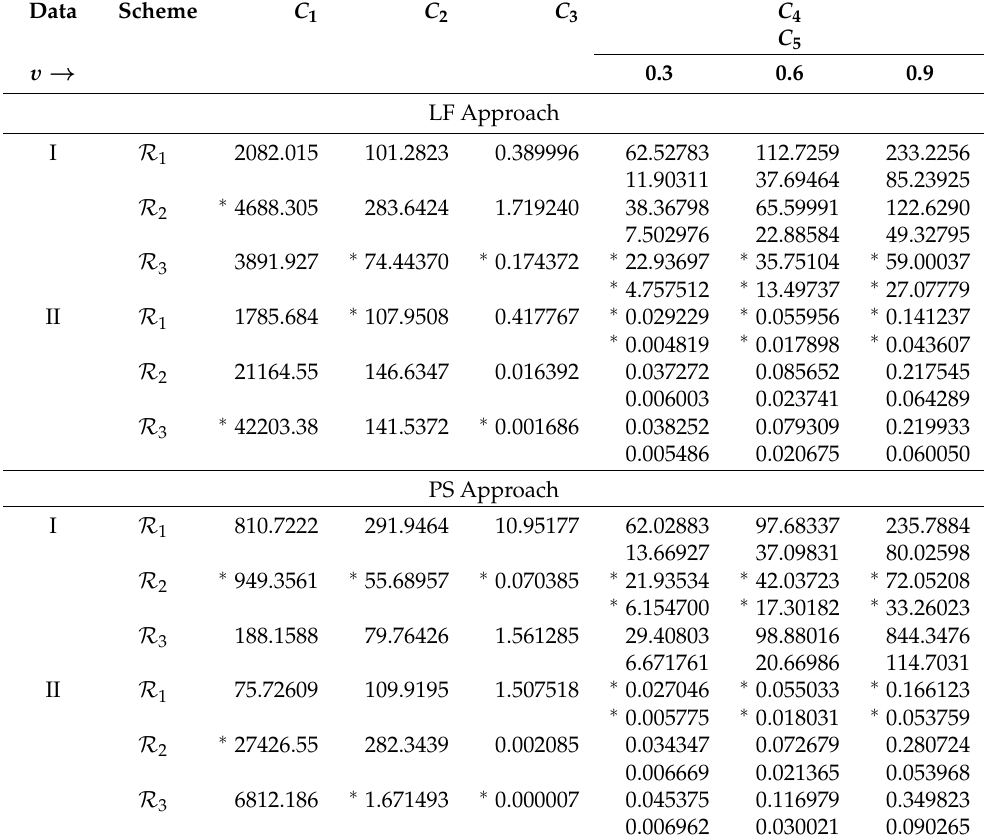
Table 8. Optimum PCS-TII plan from data sets I and